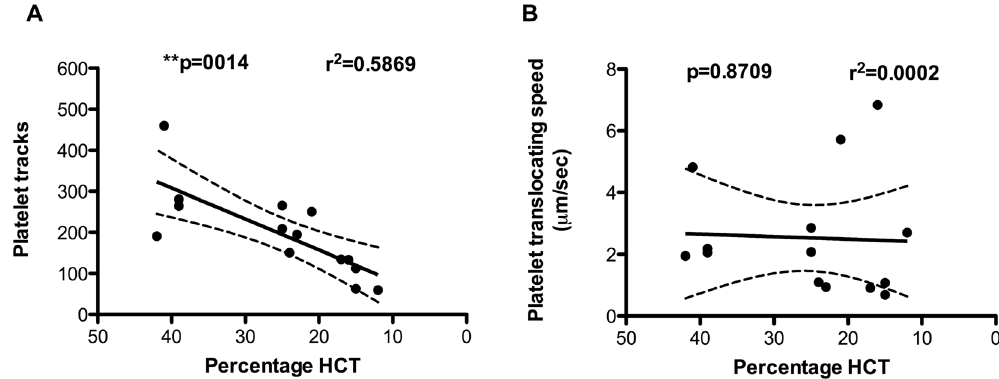
Figure 3. Decreasing haematocrit significantly reduces platelet interactions with VWF but has no effect on platelet translocation speeds. RBCs isolated from whole blood of 5 donors were diluted in platelet-poor plasma to mimic a 2-fold or 3-fold reduction in HCT, then reconstituted back into platelet-rich plasma. The blood was then perfused over VWF at arterial shear rates and measured using the dynamic platelet function assay. HCT correlated strongly with the extent of platelet interactions with VWF but not with the speed of platelet motion across the VWF surface. A simple linear regression model was used to test the slopes between the HCT and measured platelet interactions with VWF. The best-fit lines with a 95% confidence band are shown in the